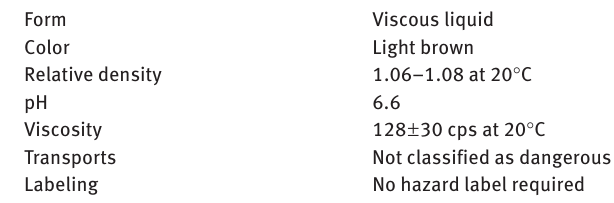
Table 3 Properties of polycarboxylic ether.